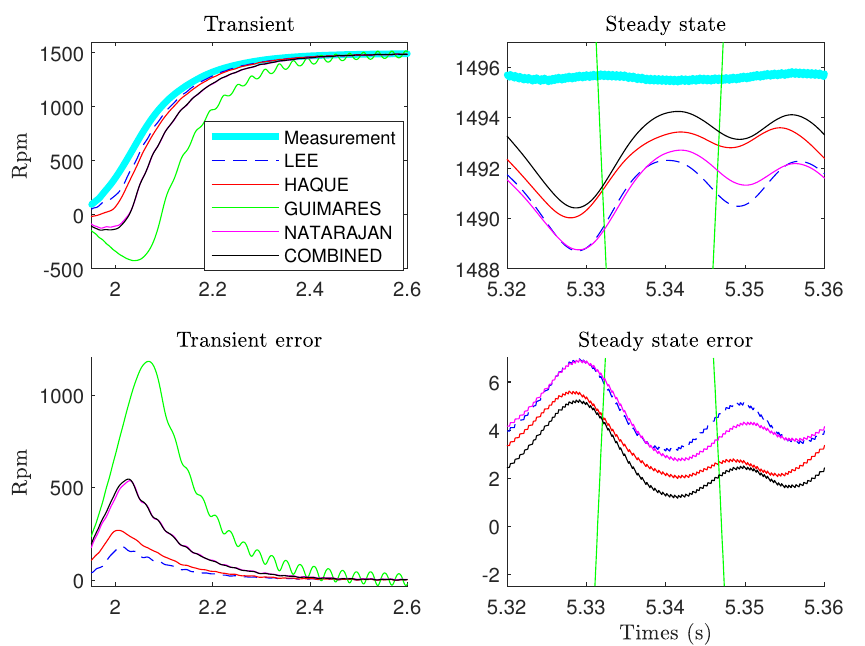
Figure 6. Comparison between measured and estimated speeds, K i = 10,000, K p = 0, G = 0.